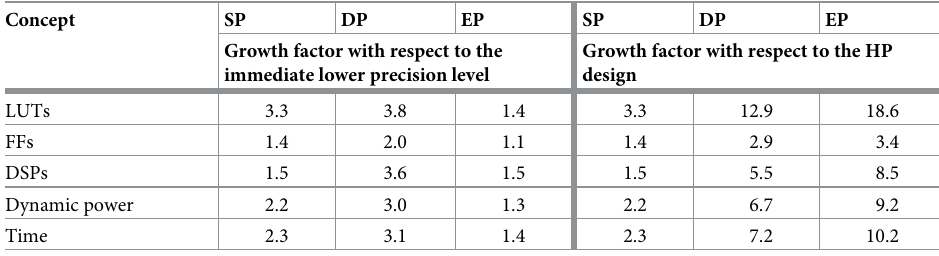
Growth factor with respect to the immediate lower precision level